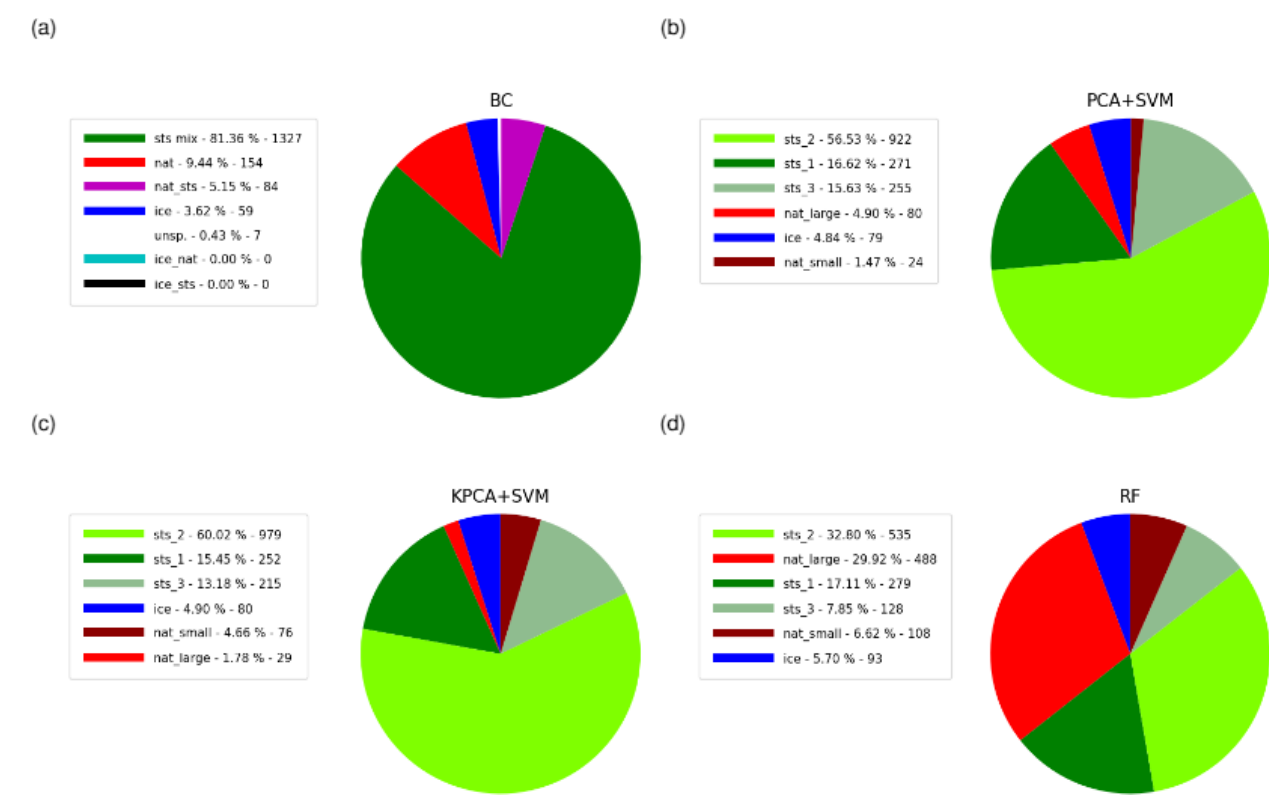
Figure 15. Same as Fig. 14 but for November 2006 to February 2007 for the Northern